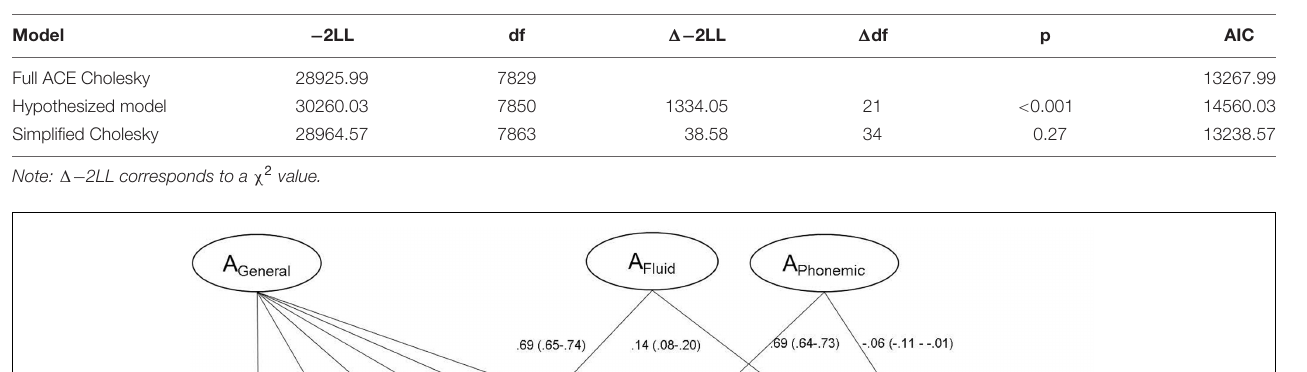
TABLE 3 | Fit statistics for the full ACE Cholesky decomposition and hypothesized model.